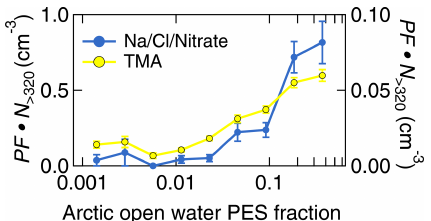
Figure 7. Aerosol composition measured by the ALABAMA as a function of FLEXPART-derived PES fraction over Arctic open- water areas during the Arctic air mass period. The panel repre- sents the scaled ALABAMA number concentration (PF · N > 320 ) with the right axis referring to Na/Cl/Nitrate-containing particles (blue) and left axis referring to TMA-containing particles (yellow). Uncertainty analyses are given in Sect. S7.